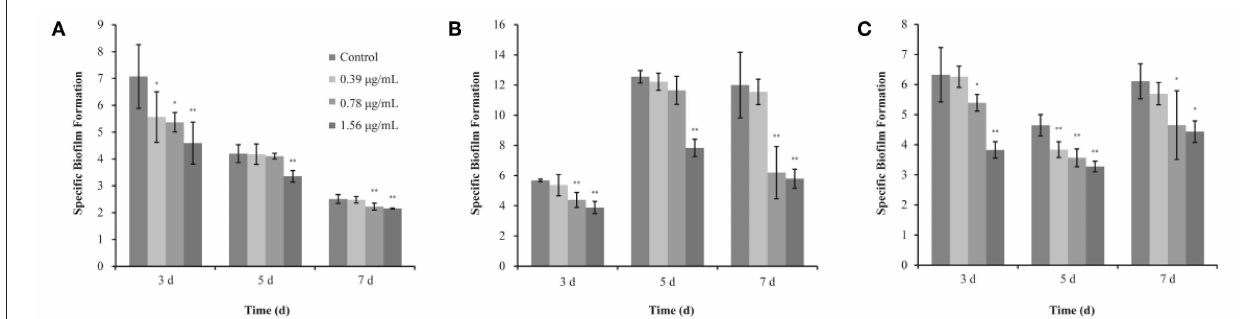
FIGURE 3 | Inhibitory effects of different concentrations of thymoquinone (TQ) on biofilm formation by Listeria monocytogenes ATCC 19115 at 37 ◦ C (A) , 25 ◦ C (B) , and 12 ◦ C (C) . Bars indicate the standard deviation ( n = 3). * P < 0.05; ** P <